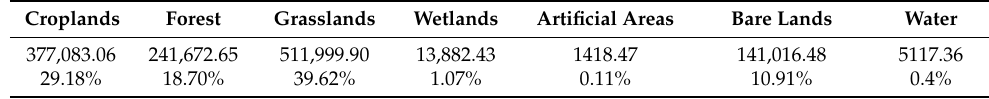
Table 4. Area and proportion of land cover types in the CLCB in 2020 (unit: km 2 ).